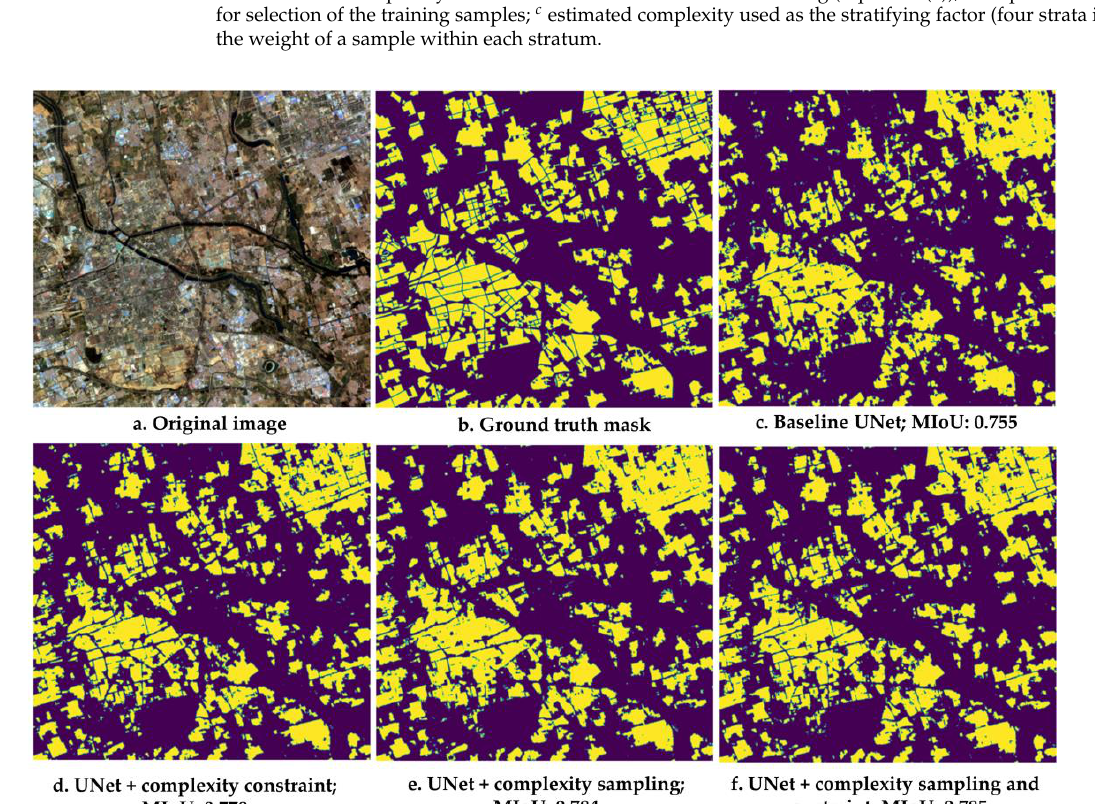
Figure 10. Comparison between farmland segmentation results of baseline UNet, UNets with com- plexity-informed constraint/sampling, and UNet with both. ( a ) shows the RGB images depicting